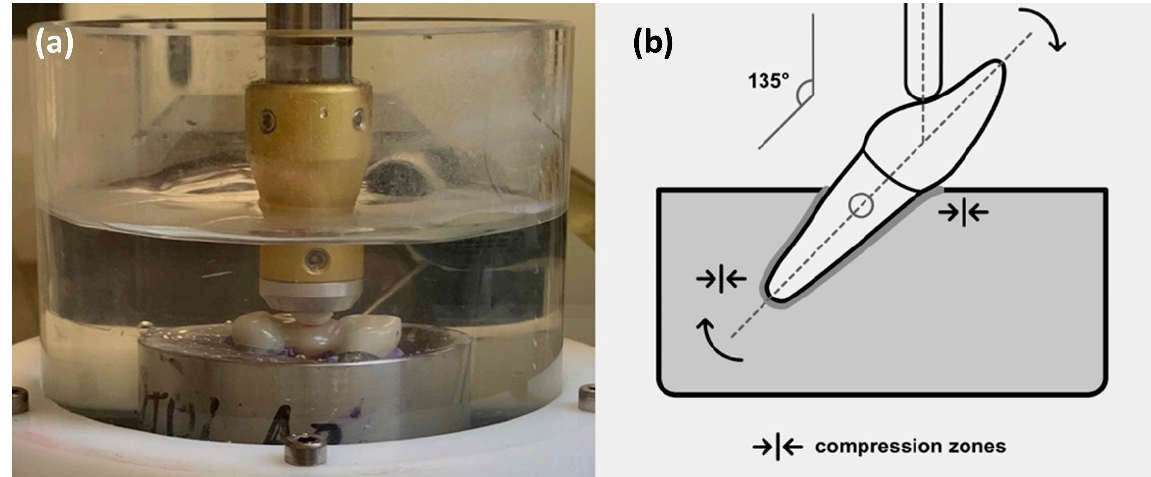
Figure 2. ( a ) Test set-up in the chewing simulator; ( b ) scheme for the test